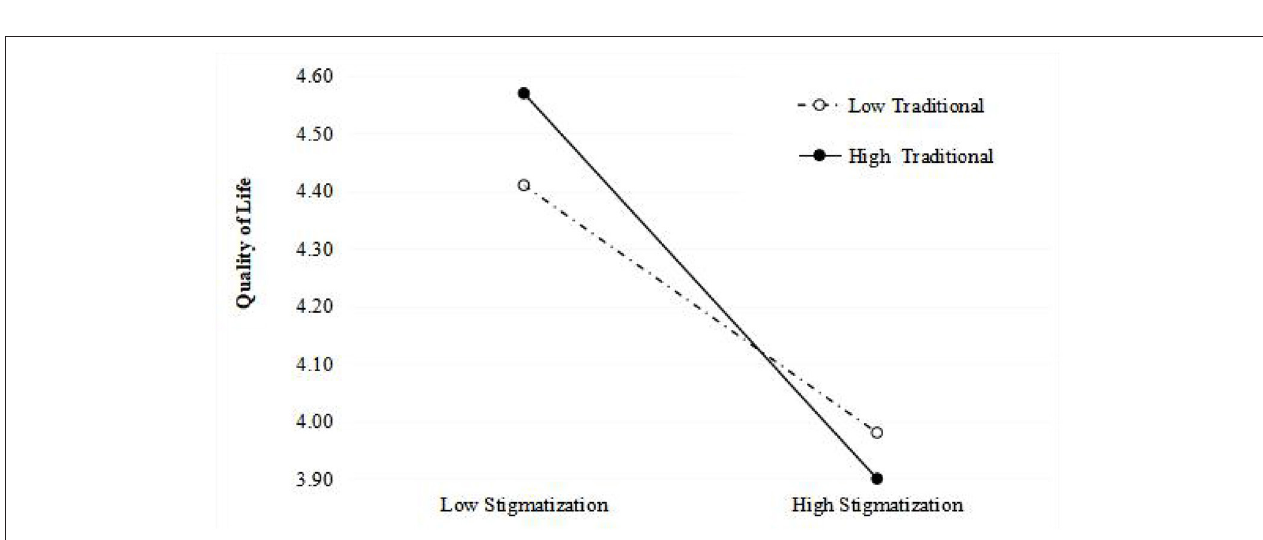
FIGURE 1 | Simple slope diagram of the influence of the interaction between self-perceived stigma and attitude toward own aging on the quality of life.